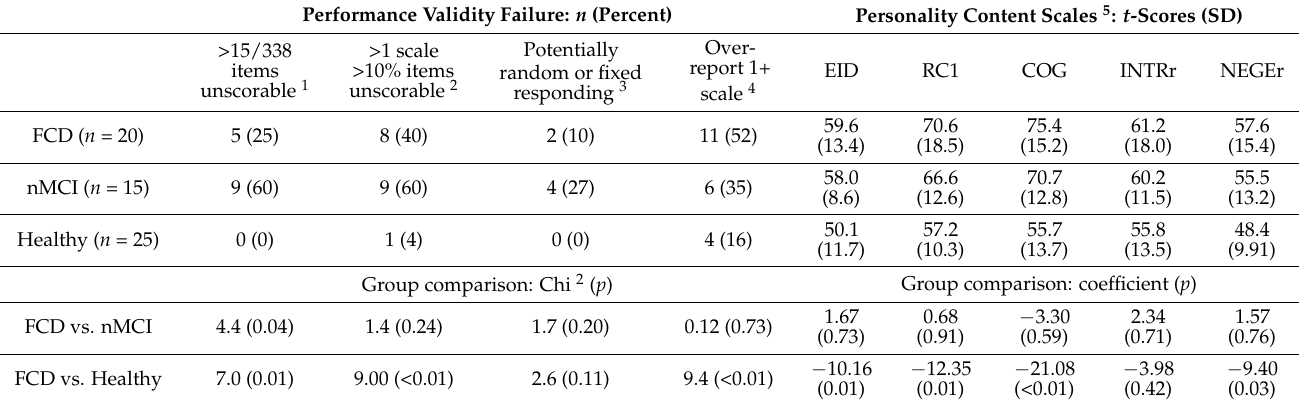
Table 4. Minnesota Multiphasic Personality Inventory (MMPI-2-RF)—validity tests and content scores per